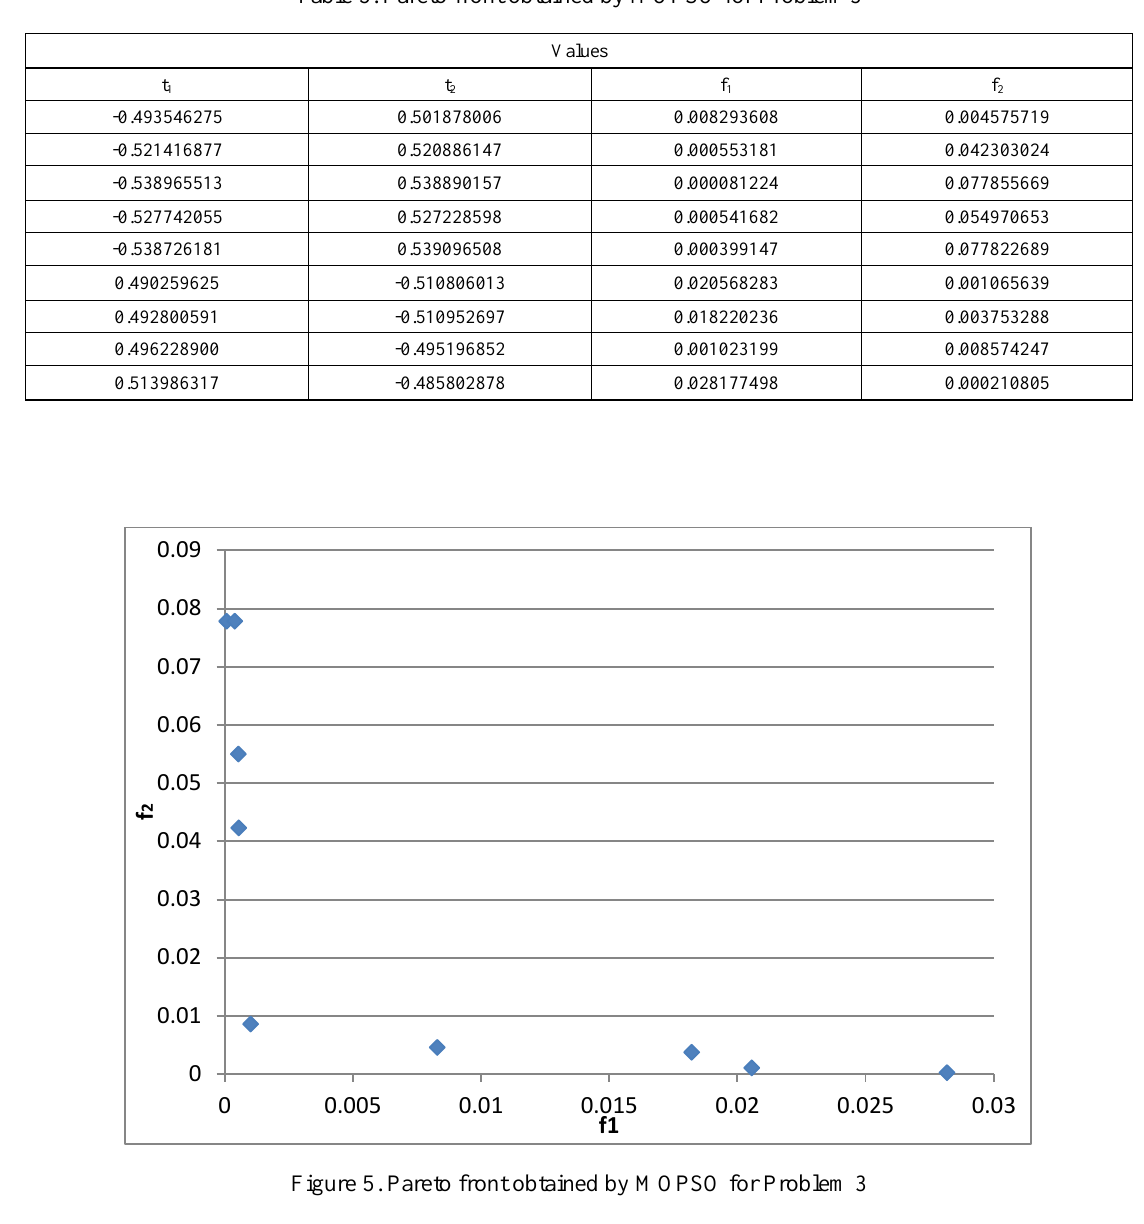
Figure 7 depicts the single solution obtained for the same problem with the grey wolf optimization algorithm, after 200 iterations and with 30 grey